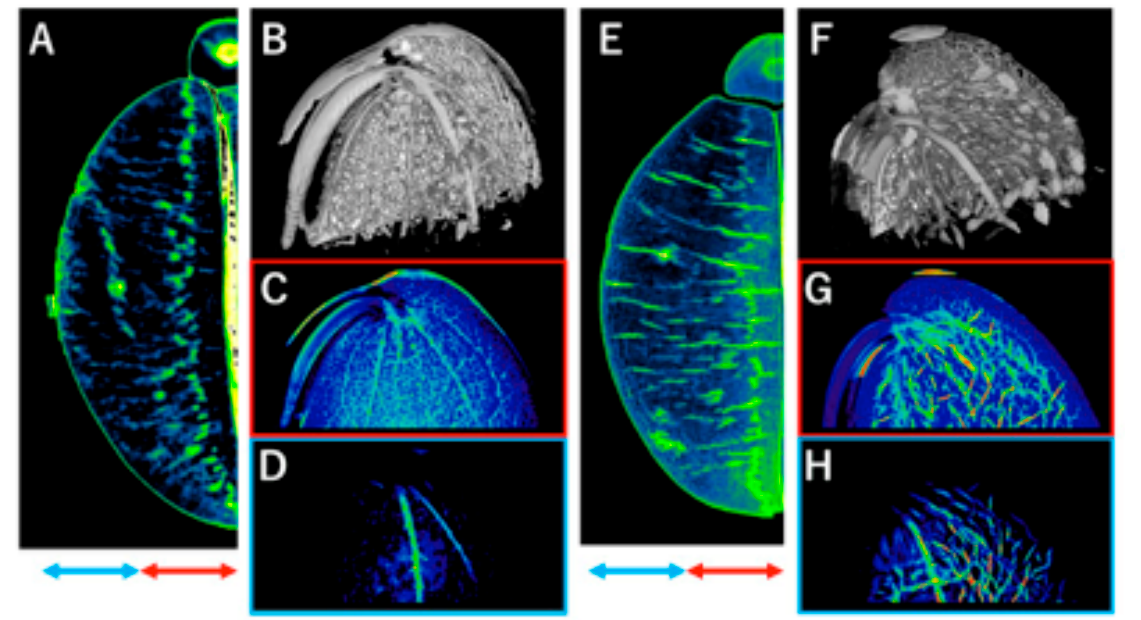
Figure 4. Three-dimensional and projection images of edamame beans. Visualization of vascular tissue with images ( B , F ) reconstructed in the low-density portion of the cotyledon ( A , E ). The projection images were reconstructed in the parts near to (indicated by the red, double-headed arrow, ( C )) and far from (indicated by the blue, double-headed arrow, ( D )) the gap between the cotyledons in A, and similarly, the projection images ( G , H ) were reconstructed in the parts near to and far from the gap between the cotyledons in ( E ). The images were created by projection in the direction of the double-headed arrows. The average values of the pixel intensities are projected, and lower integrated values in red indicate lower density. Blue, yellow, and red indicate high-, intermediate-, and low-density values, respectively. Materials that were not boiled and materials that were boiled for 2 min were used in ( A – D ) and ( E – H ),